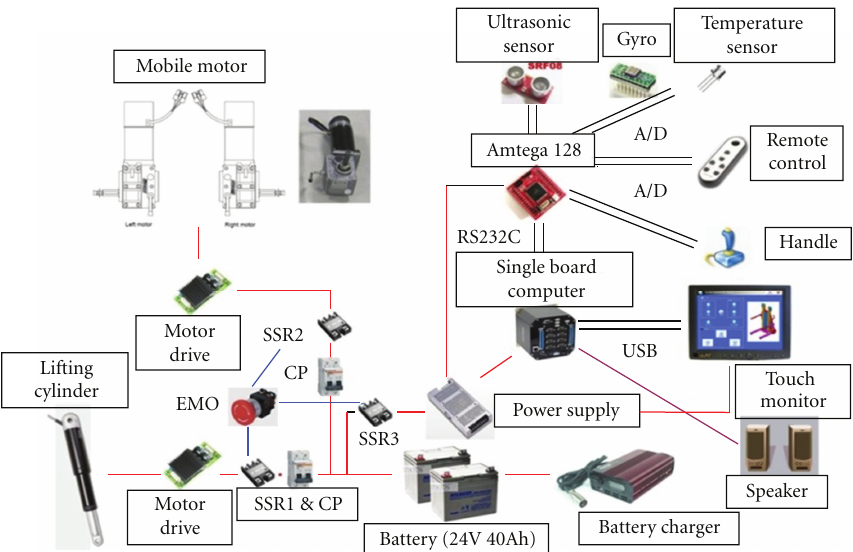
Figure 18: The control architecture and